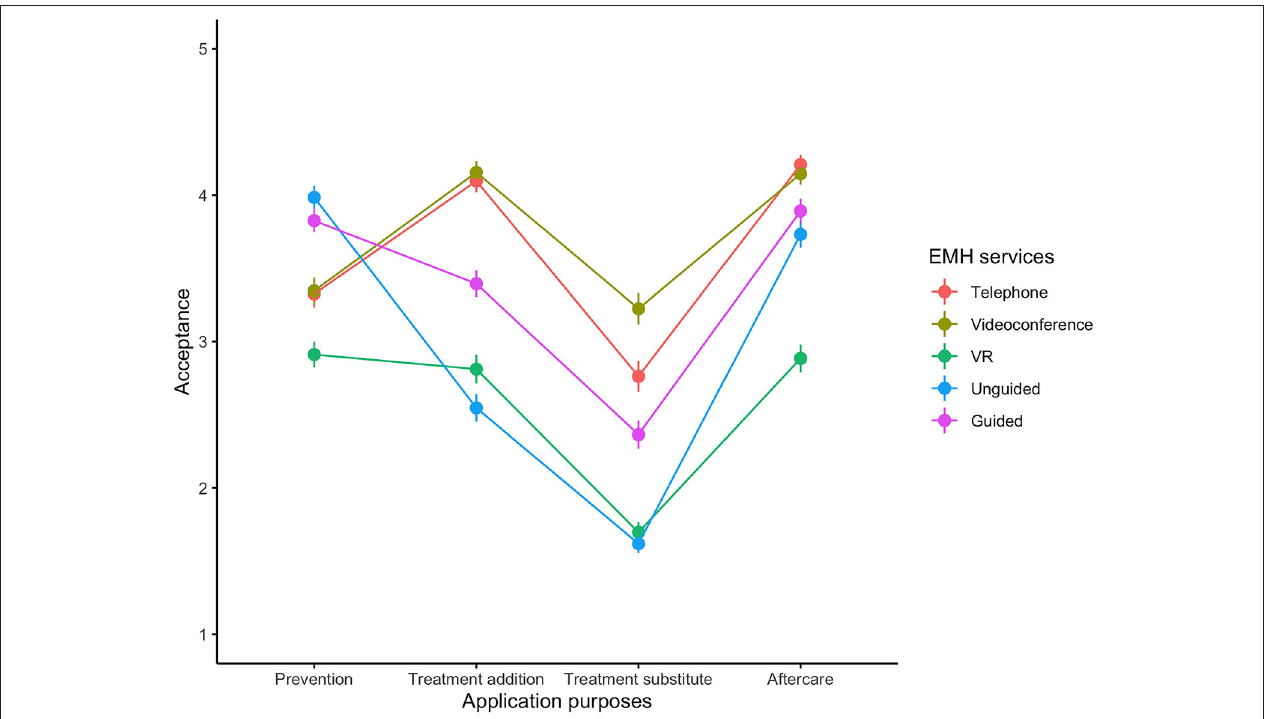
FIGURE 2 | Mean Acceptance Scores for different EMH Services across Application